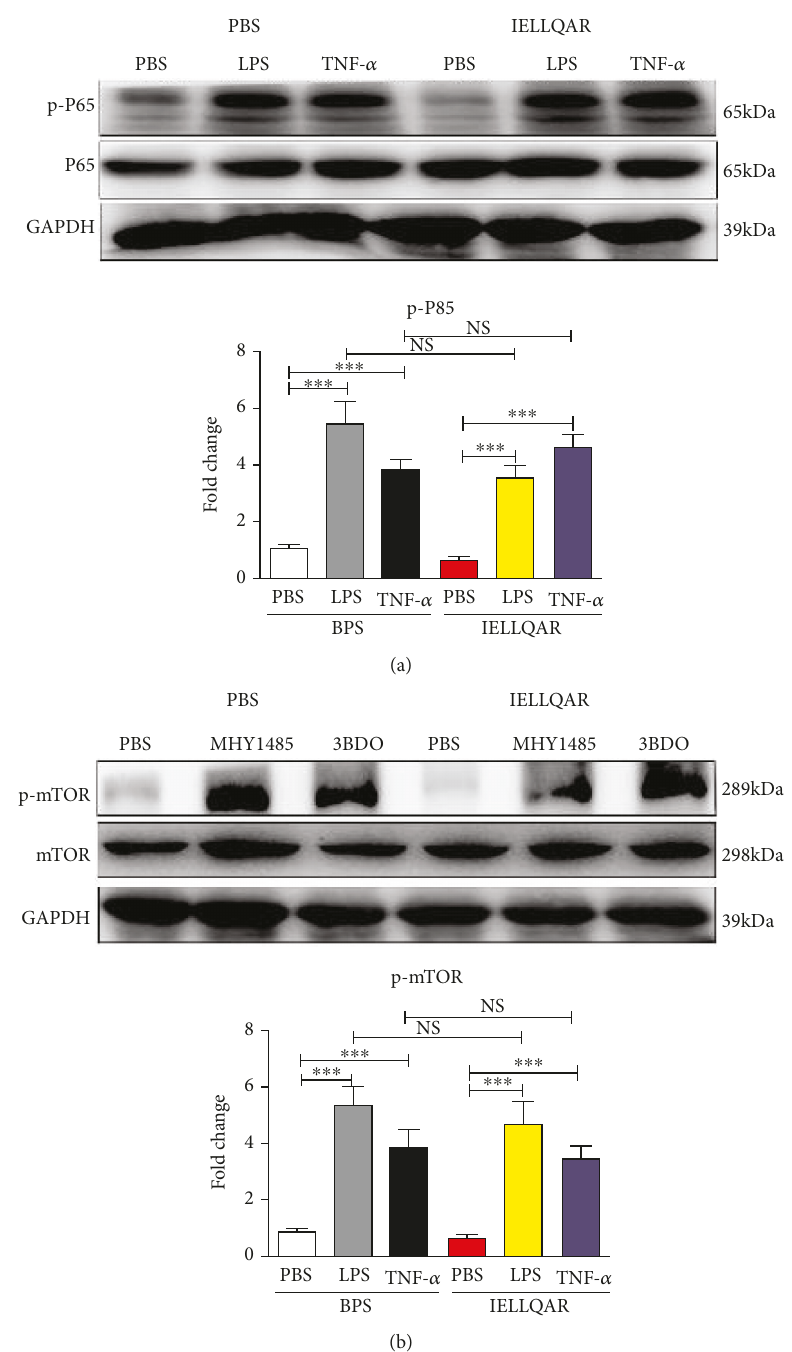
Figure 8: IELLQAR failed to directly inhibit the NF- κ B and mTOR pathways. (a) PBMCs were treated with 1 μ g/ml LPS or 100 ng/mL TNF- α in the presence or absence of IELLQAR for 30 min. Representative Western blots showing the expression levels of total and phosphorylated P65. (b) PBMCs were treated with 2 μ M MHY1485 or 60 μ M 3BDO in the presence or absence of IELLQAR for 30 min. Representative Western blots showing the expression levels of total and phosphorylated mTOR. The intensities of the protein bands were quanti fi ed and are presented as the ratio of phosphorylated protein/total protein after normalization to GAPDH. Data are presented as the mean ± SEM ( n = 3 ). ∗ p < 0 05 , ∗∗ p < 0 01 , and ∗∗∗ p < 0 001